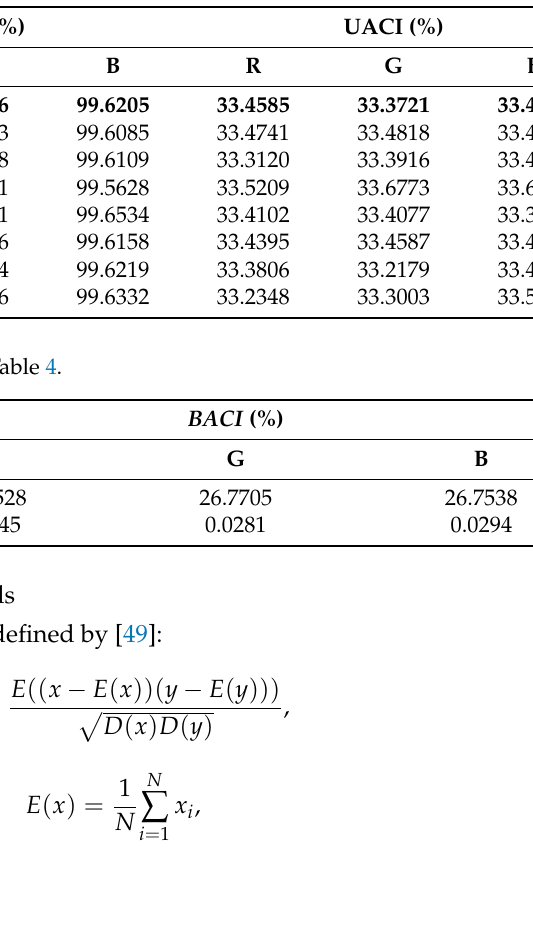
Table 8. Comparison of NPCR and UACI using image Peppers (The bold part is the relevant values of the proposed algorithm).